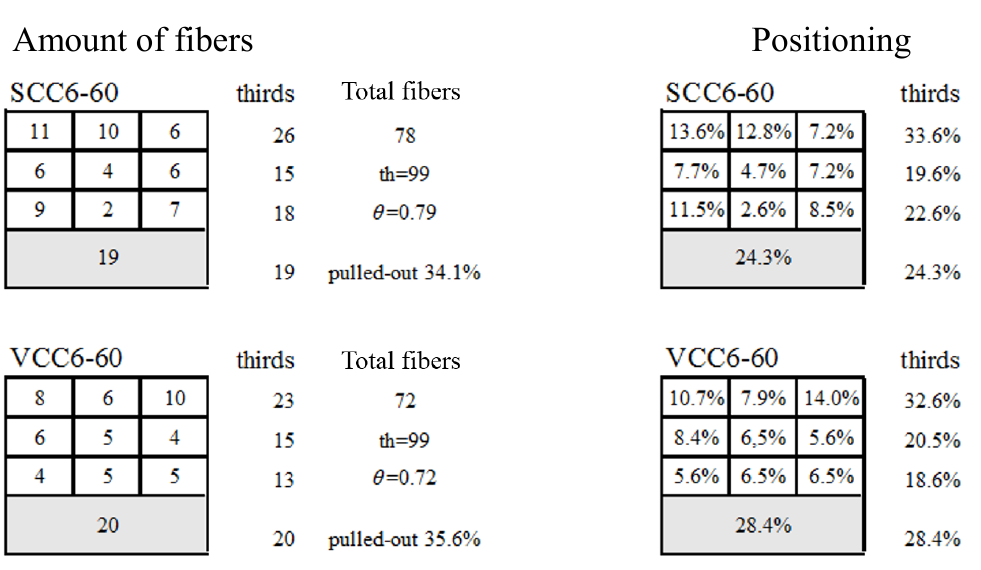
Figure 8. Counting exercise performed in SCC6-60 and VCC6-60 (including the percentage of pull-out fibers).